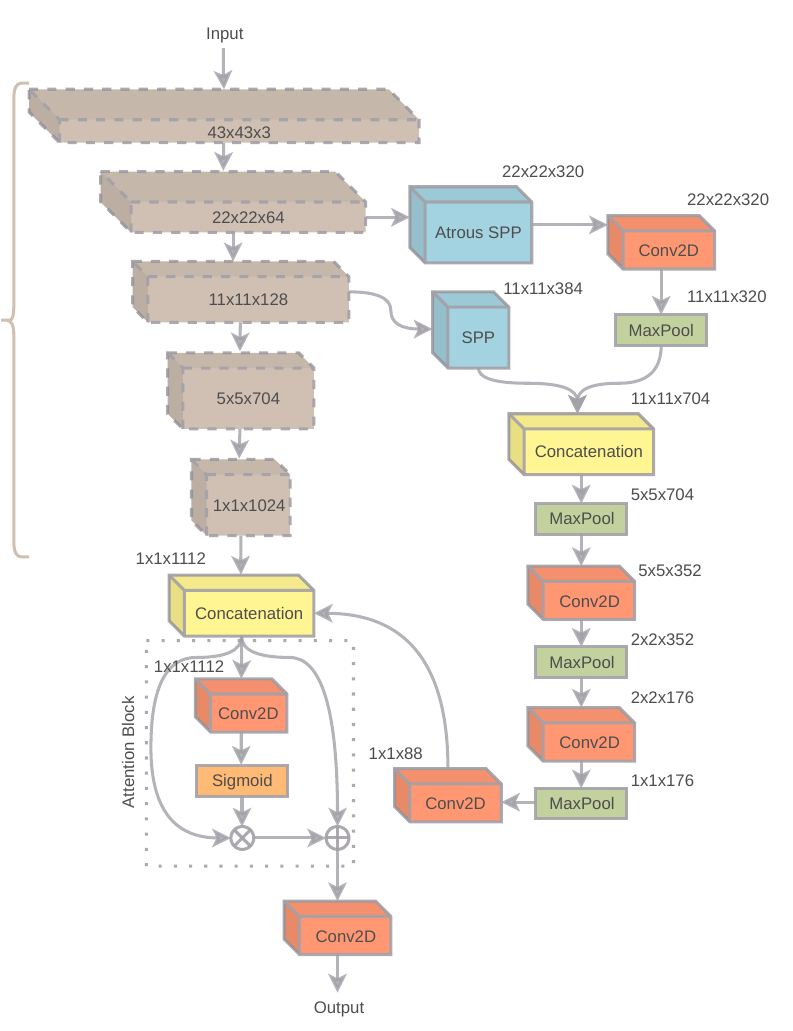
Figure 4. The figure explains the architecture of the embedding model. The given input (image patch) is passed through a frozen DCNN backend. Parallelly, ASPP and SPP blocks operate from two output dimensions (22 × 22 × 64 and 11 × 11 × 128, respectively) of the DCNN backend. The outputs of ASPP and SPP are concatenated, convolved, and finally merged with the DCNN backend’s output. The output is followed by a small attention block and generates final patch-based descriptors.